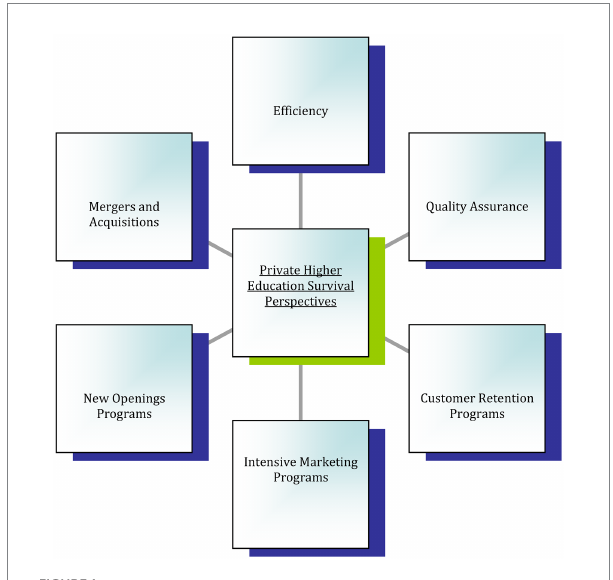
FIGURE 1 Private higher education survival